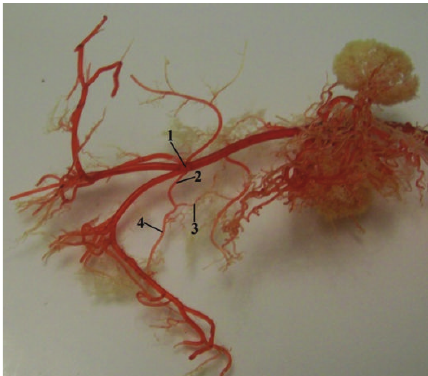
Figure 9: Photograph showing the common trunk of the a. mesen- terica cranialis with the a. renalis dextra . 1: aorta abdominalis , 2: a common trunk, 3: a. mesenterica cranialis , and 4: a. renalis dextra (casting medium PUR SP).